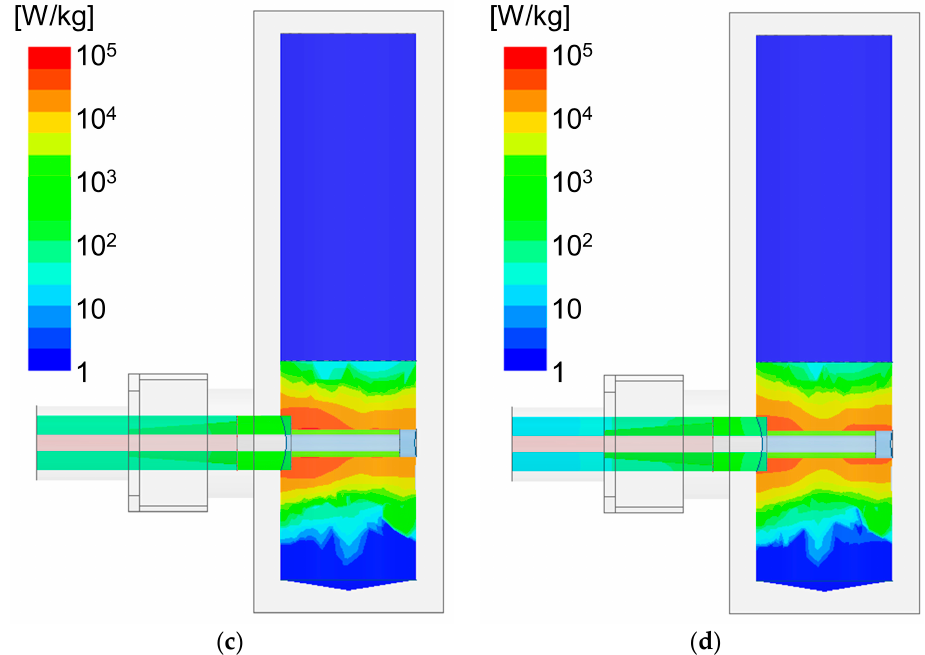
Figure 8. Simulated absorbed power distribution in the cylindrical applicator using liquid samples of water at ( a ) 2.45 GHz and ( b ) 1.7 GHz, and a NaOH solution at ( c ) 2.45 GHz and ( d ) 1.7 GHz.